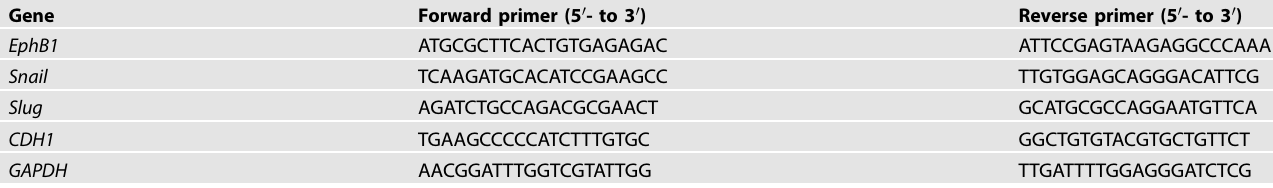
Table 2. Primer sequence for Real-Time